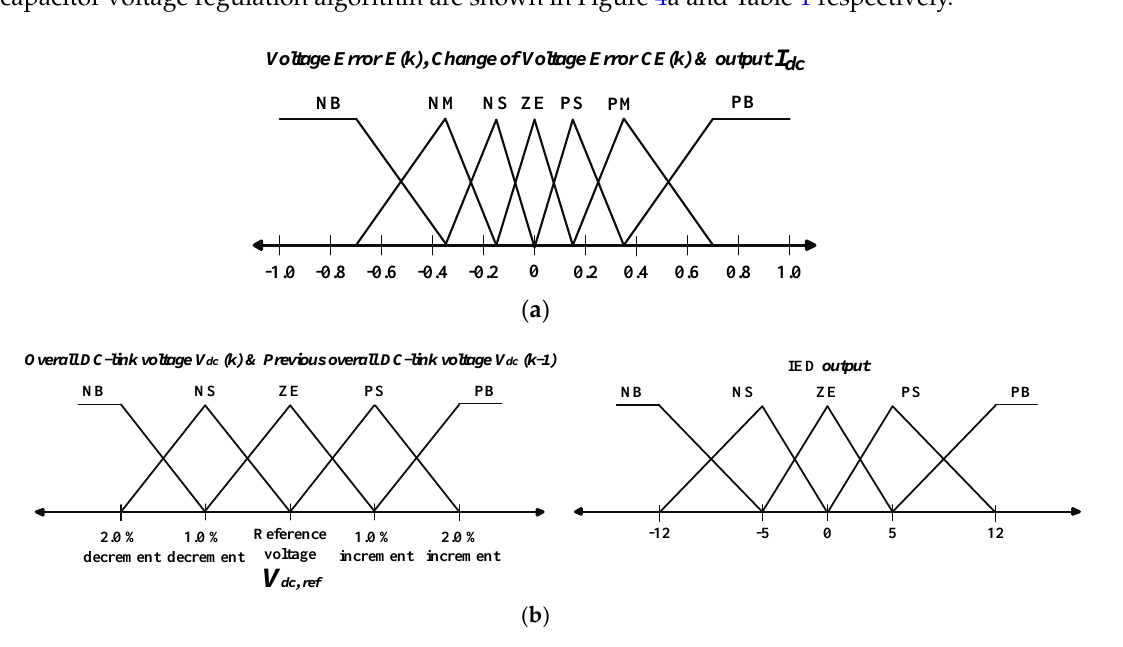
Table 1. Fuzzy rule base for the conventional algorithm with FLC technique [20,21,26,27].